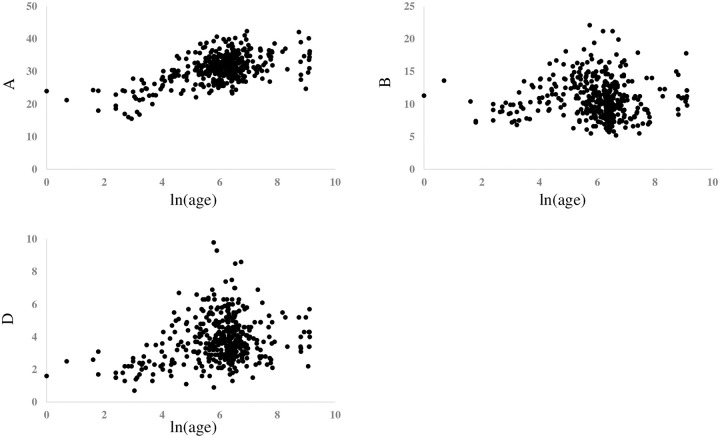
Width of the ventricle of those in normal control plotted in relation to ln(age), revealing that A was weakly correlated with ln(age), however absent in linear correlation in B and D.Results of regression analysis and Spearman’s rank correlation analysis is shown in separate table. A: Maximum distance between anterior horn, B: Minimum bicaudate nuclei distance, D: Third ventricle distance.